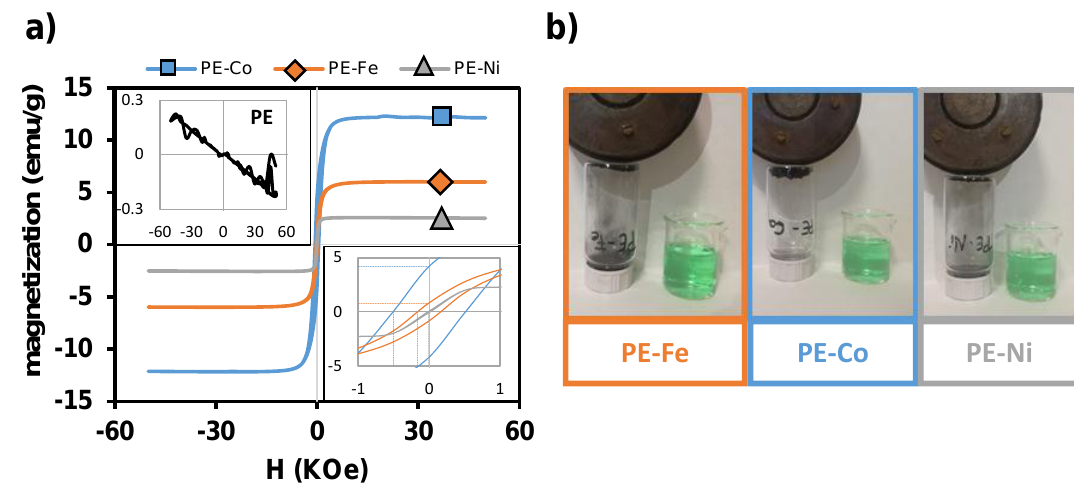
Figure 7. Magnetic behaviour: ( a ) Magnetic susceptibility at 293 K. ( b ) Pictures showing magnetic properties.